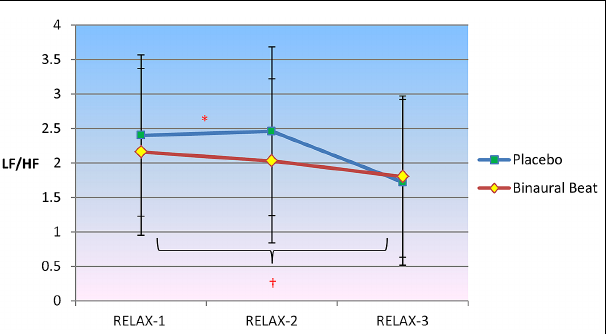
FIGURE 3 | Differences in the trajectory of low-frequency (LF) power (representing a combination of sympathetic and parasympathetic influences) over the course of relaxation between binaural-beat and placebo conditions. Error bars represent ± 1 SE of the marginal mean. *Condition × Time interaction is significant at p < 0.05. η Marginal means are significantly different at p < 0.05. † Simple main effect of time